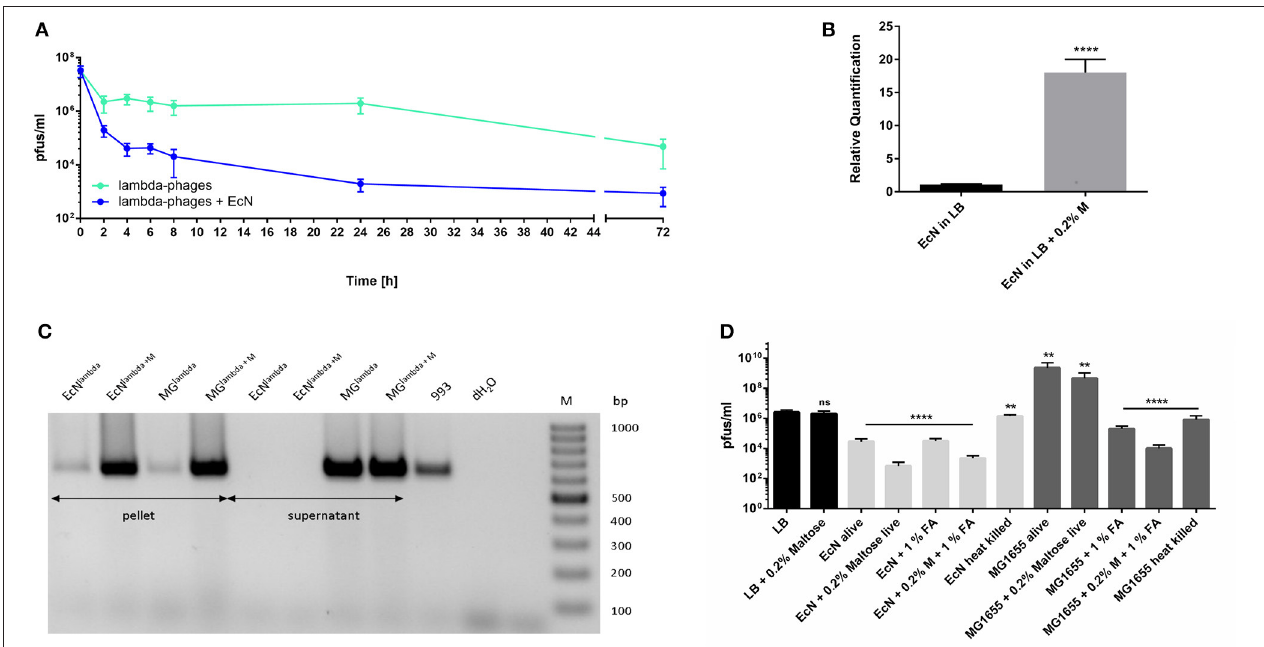
FIGURE 4 | Phage inactivation studies of EcN and lambda-phages. (A) The lambda-phage pfus/ml kinetics were analyzed in the presence and absence of EcN in a period of 72 h. Phage titers were determined with the Phage Plaque Assays (PPA). (B) The lamB regulation of EcN was evaluated after 6 h incubation in LB medium with or without the addition of 0.2% maltose with qRT-PCR. hcaT was used as control gene. (C) To determine the phage localization, a PCR with the lambda Q primers was performed on the washed bacterial pellet or the sterile filtered supernatant of EcN or MG1655 after being incubated with lambda phages for 24 h in the absence or presence ( + M) of 0.2% Maltose. 993 is the E. coli K-12 strain that harbors lambda lysogen and it was used as positive control for this PCR (D) Heat killed or 1% formaldehyde (1% FA) fixed EcN or MG1655 were compared in their phage inactivation capabilities to the corresponding alive E. coli . Bacteria were incubated with or without 0.2% Maltose for 24h, static before being killed. The lambda-phages were incubated for 24 h with the living or dead E. coli strains and subsequently the phage titer was determined with the PPA. ns, not significant, ** p < 0.01 and **** p <